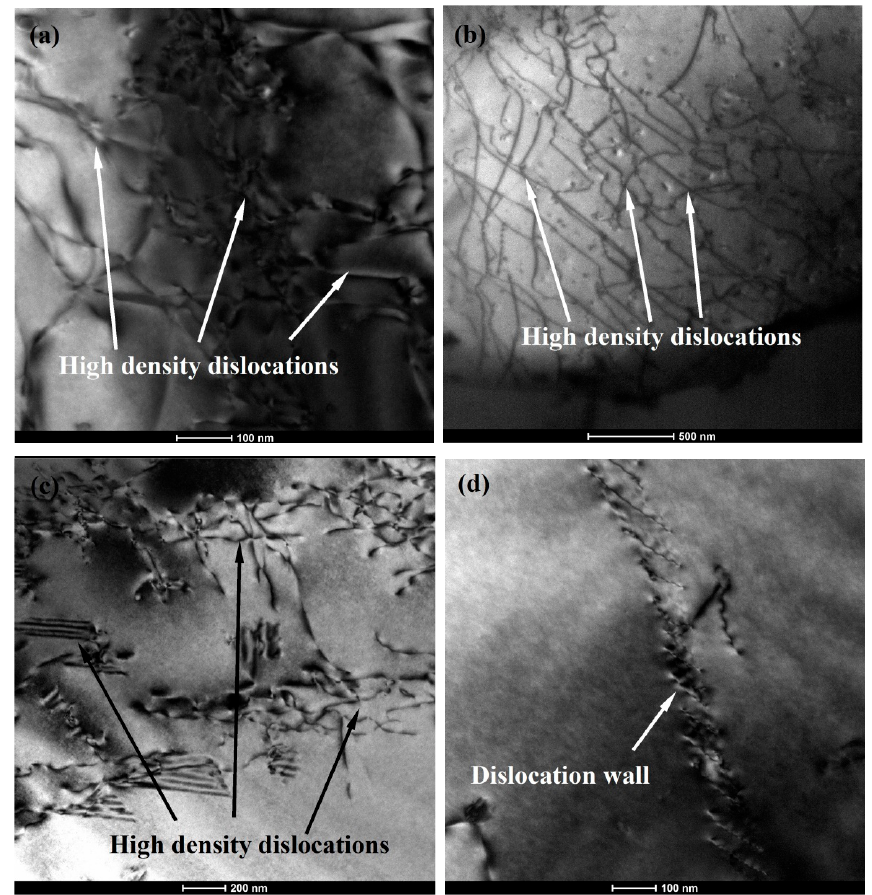
Figure 8. Transmission electron microscopy (TEM) images in location B of the thixoformed composite parts at different remelting temperatures ( a ) 580 °C, ( b ) 590 °C, ( c ) 600 °C, ( d ) 610 °C. The microstructure of the thixoformed part soaked for different times at 600 °C is presented in Figure 9. As indicated in Figure 9, a large number of elongated grains were found in the microstructure. Furthermore, the elongated extent of the solid grains with a soaking time of 15 min is